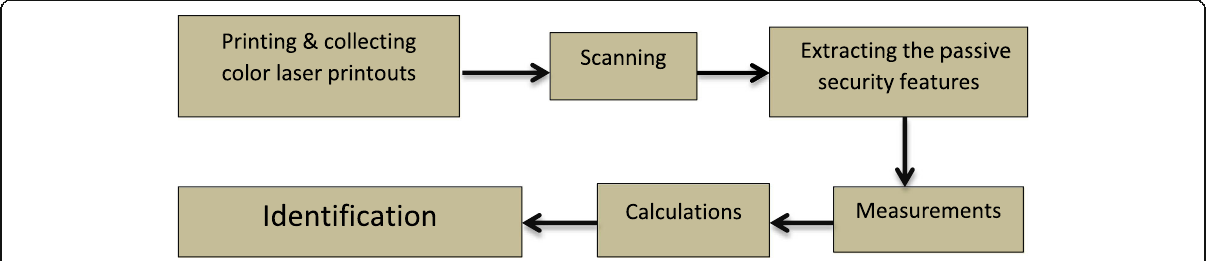
Fig. 1 The defined steps for identifying the color laser printer source